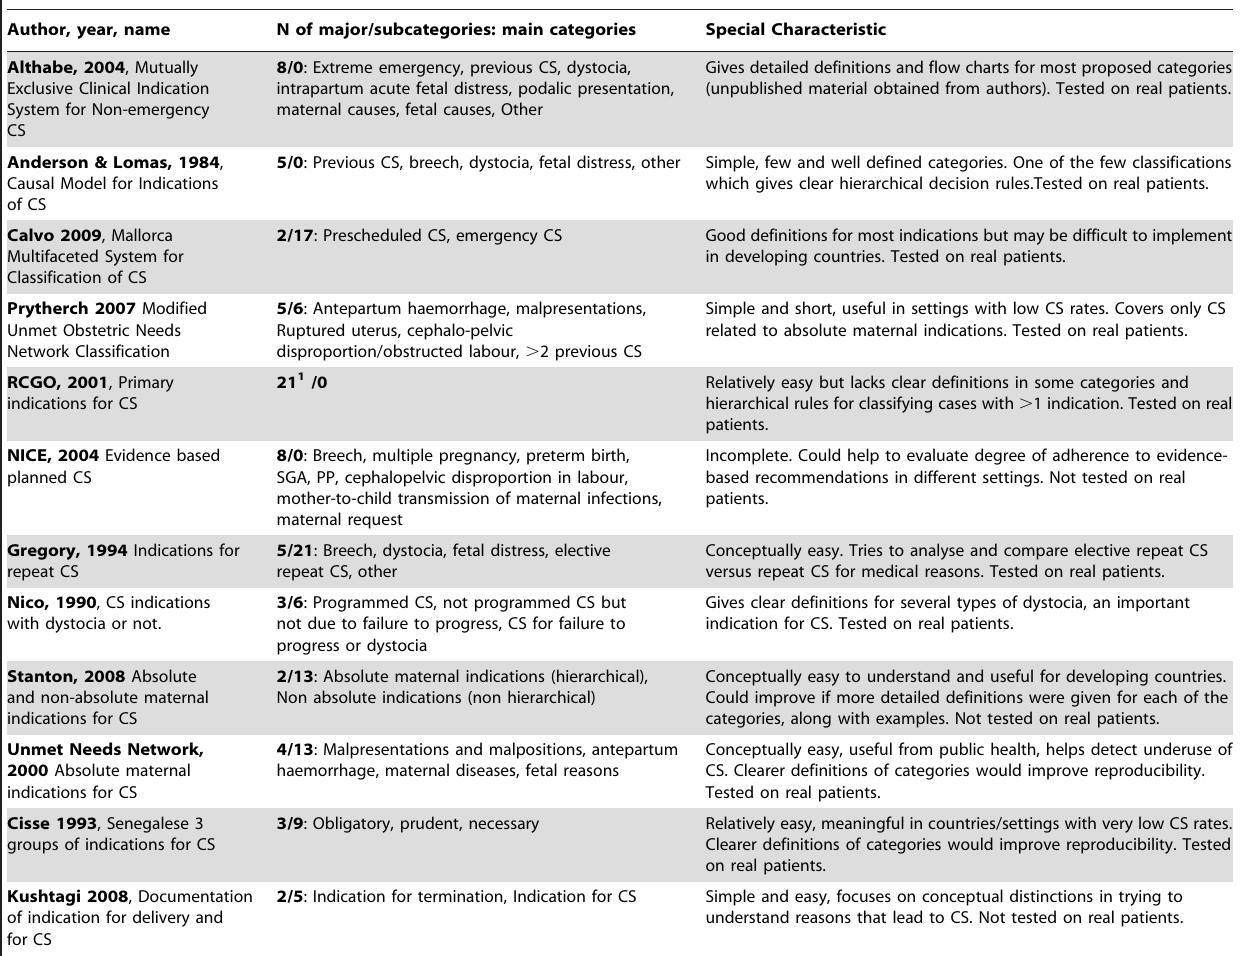
Table 4. Classifications for caesarean sections based on